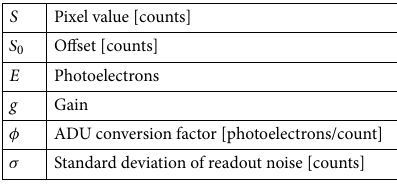
Table 1. Variable